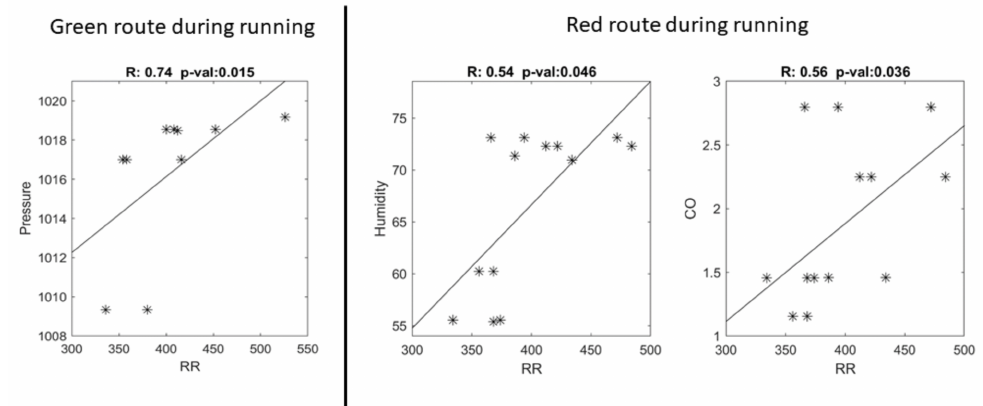
Figure 4. On the left is the scatterplot of the significant correlation between data during running for the green route (RR interval and atmospheric pressure), and on the right are the significant correlations between data during running for the red route (RR interval and relative humidity, and RR interval and CO concentration). The scatterplots report the lines of best fit, the Spearman’s correlation coefficients (R), and associated p -values ( p -value). The RR interval is expressed in msec, atmospheric pressure in hPa, relative humidity in percentage, and CO in